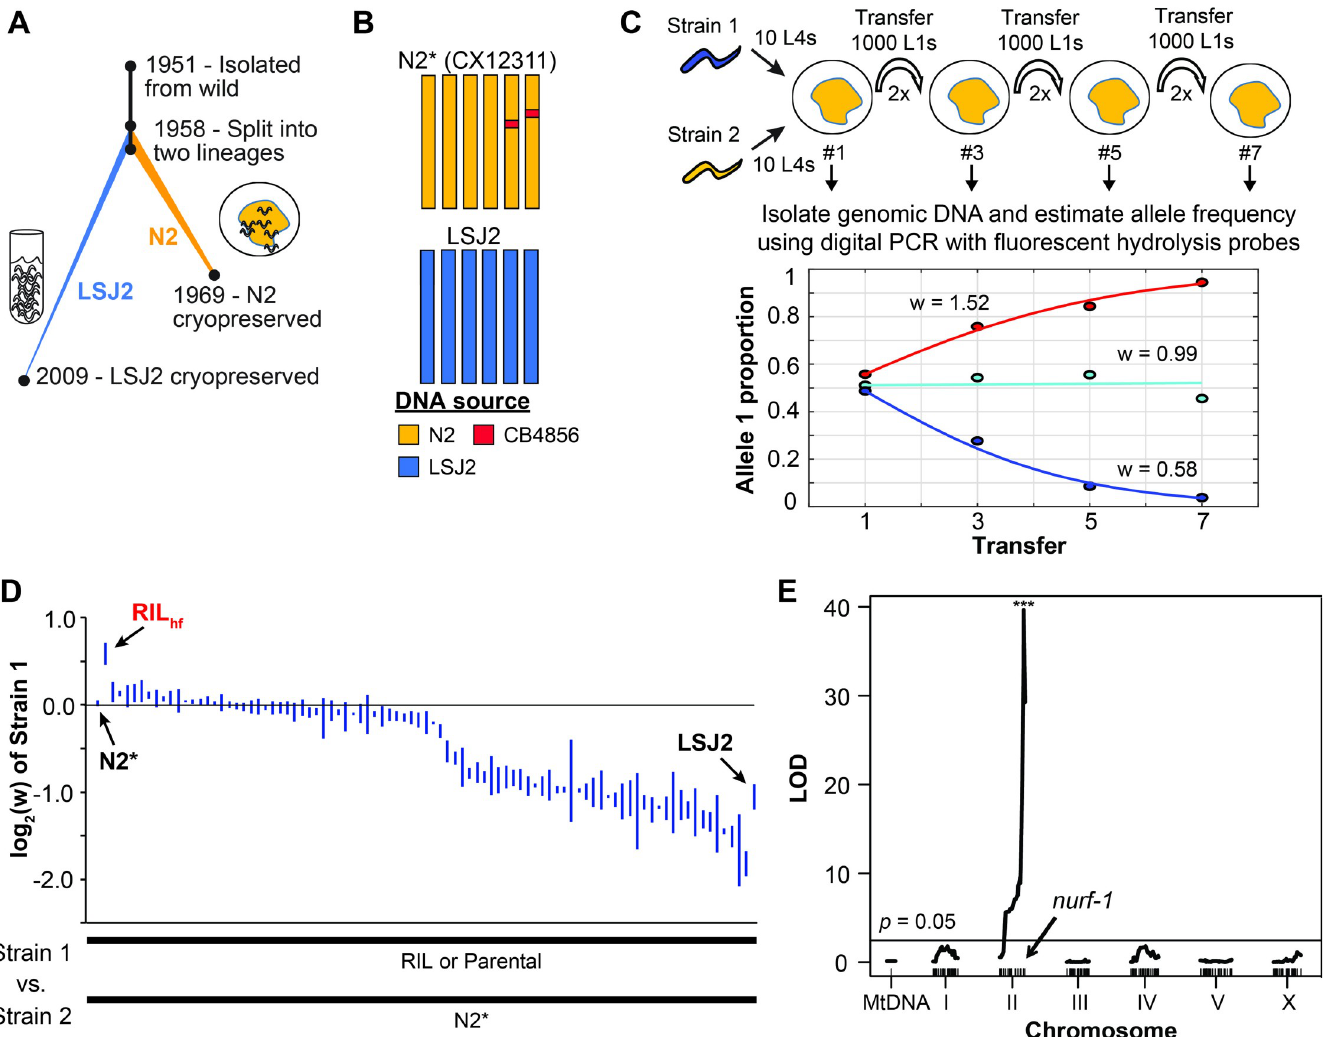
Fig 1. Competitive fitness measurements of N2 � /LSJ2 RILs identifies an outlier RIL. (A) Overview of the life history of two laboratory strains of C . elegans since their isolation from the wild in 1951 and subsequent split into two separate lineages around 1958. The standard reference N2 strain was cultured on agar plates seeded with E . coli bacteria until methods of cryopreservation were developed. LSJ2 was cultured in liquid, axenic media until 2009 when a sample of the population was cryopreserved. Resequencing of these strains identified ~300 genetic differences that fixed in one of the two lineages. (B) Schematic of two parental strains used in high-throughput analysis. N2 � (or CX12311) is a near-isogenic line (NIL) containing ancestral alleles of two genes, glb-5 (chromosome V) and npr-1 (chromosome X) backcrossed from the CB4856 wild strain. Beneficial alleles in these two genes fixed in the N2 lineage; use of the N2 � strain allows us to exclude the effects of these alleles from our studies. (C) Example data for three pairwise competition experiments used to quantify the fitness differences between two strains in laboratory conditions. Every odd generation, allele proportion is quantified using digital PCR and fluorescent hydrolysis probes (dots). These points are used to estimate the relative fitness of strain by fitting a haploid selection model to these points (line). In these conditions, outcrossing is expected to be very low or absent due to the lack of males in the initial population. (D) Relative fitness levels were measured for a panel of 89 RIL strains generated between N2 � and LSJ2 by competing each RIL against N2 � for seven generations. RILs were ordered by their average fitness value (3 replicates were performed for each). Parental strains were also assayed (N2 � and LSJ2). RIL hf (red) is highlighted for its unusually high fitness. (E) QTL mapping on the relative fitness differences between the RIL strains. A single significant QTL on the right arm of chromosome II, which overlaps the previously identified nurf-1 gene, was identified. Threshold line is significance level at p = 0 . 05 from a 1,000 permutation test.